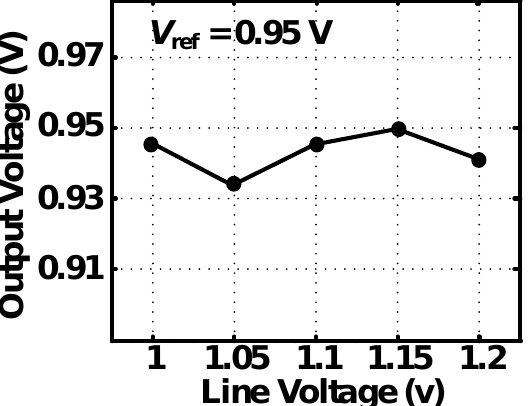
Figure 12. The output voltage under the variations of line voltage.